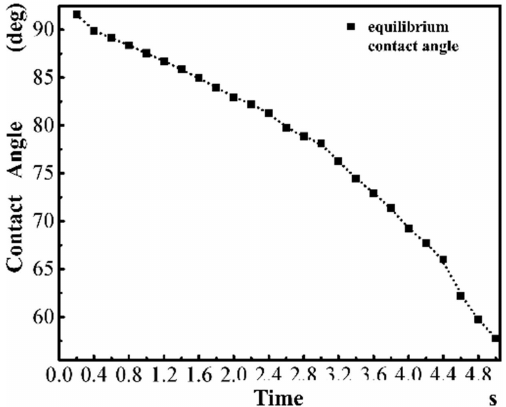
Figure 4. A chart of equilibrium contact angles during ultrasonic wetting period, CA values are measured from wetting snapshots in every single 0.2